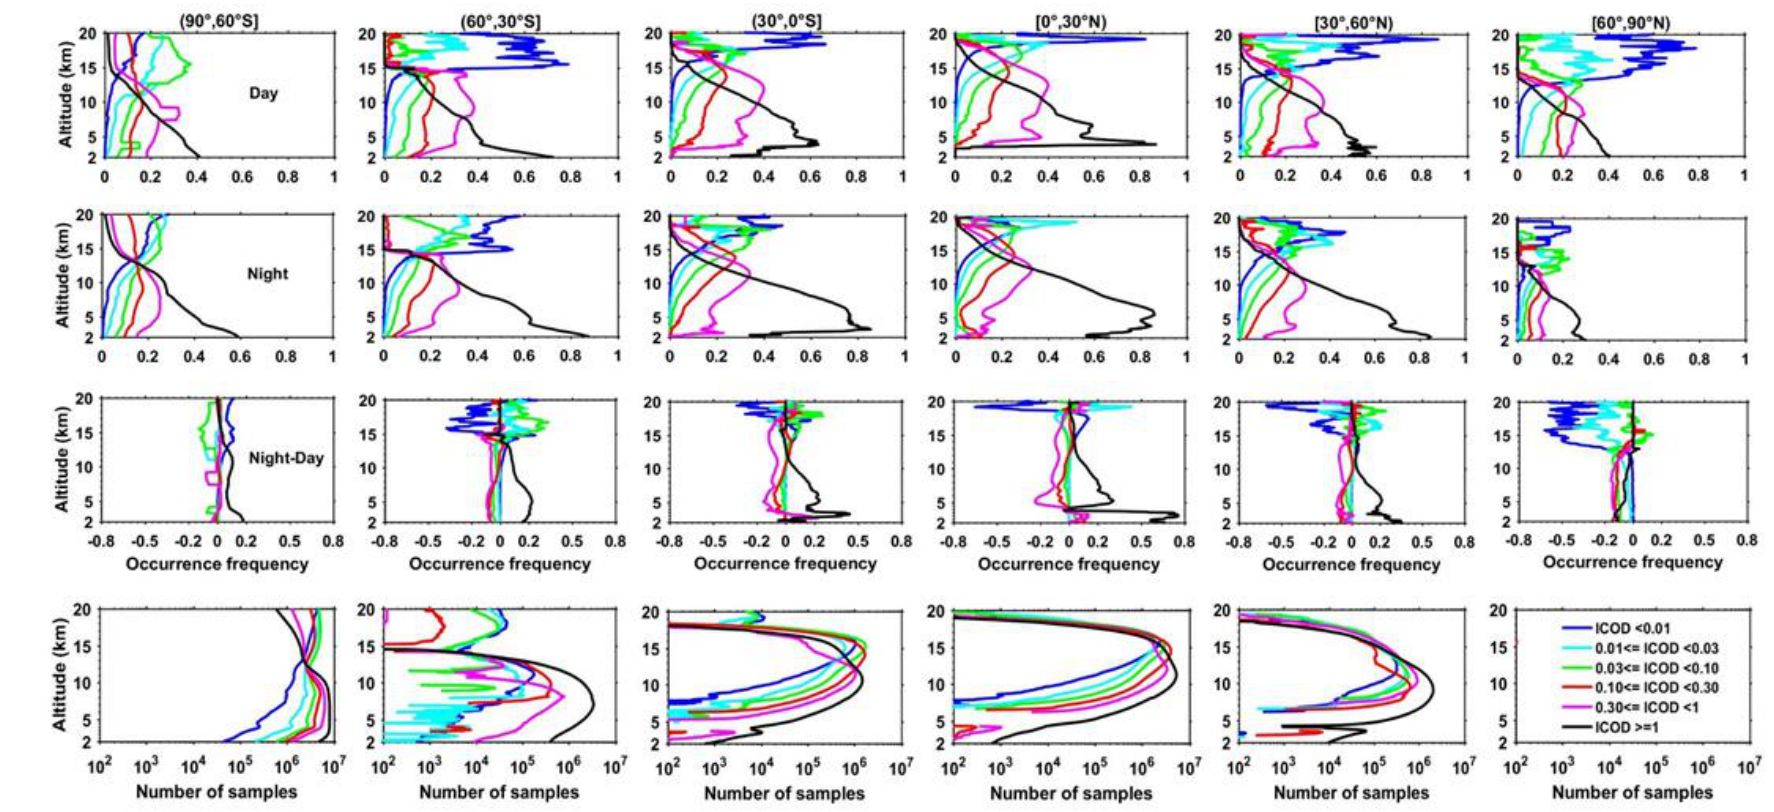
Figure 6. Day and Night observations of zonal mean profiles of the frequency of occurrences of ICOD over six groups (the first and second rows), Diurnal variation (Night-Day) of the frequency of occurrence profiles, and total number samples of ICOD over six groups (the third and fourth rows), obtained from the 10-year CALIOP summertime measurements.